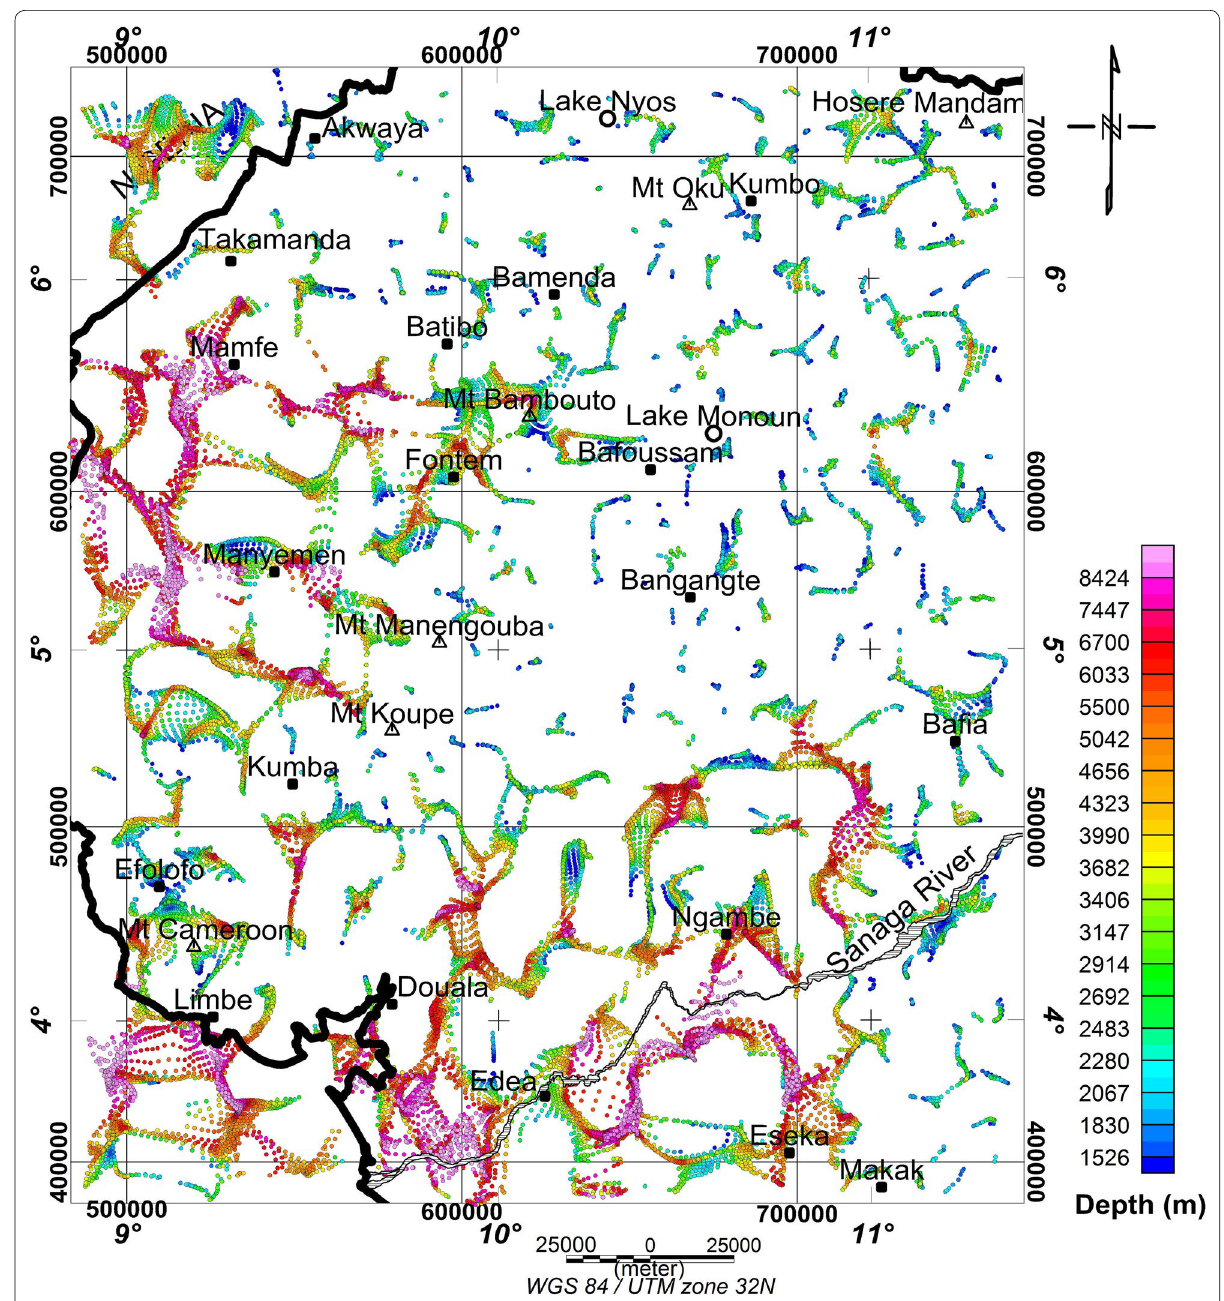
Fig. 9 Deconvolution Euler map with a structural index of